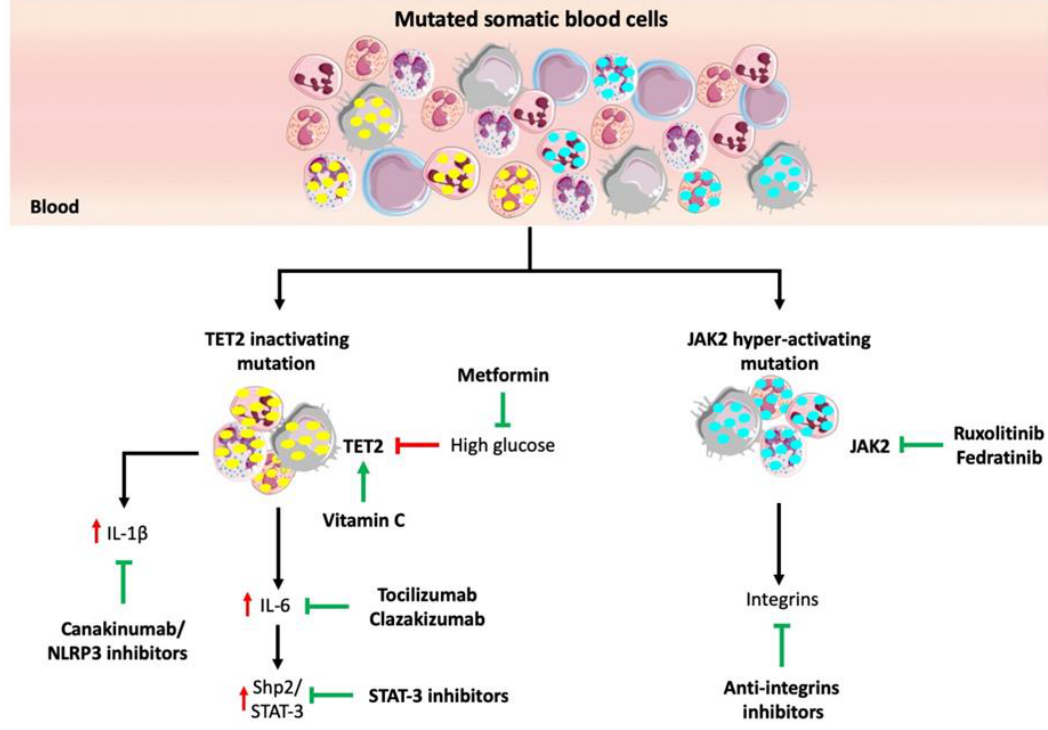
Figure 2. Potential strategies of targeting high-risk CHIP mutations. TET2 deficiency causes the increased expression of IL-1 β and IL-6, which in turn activates the Shp2 / STAT-3 signaling axis. Antibodies targeting IL-1 β and IL-6, NLRP3 or STAT-3 inhibitors could mitigate the e ff ect of a CHIP-mediated inflammation response. High glucose levels destabilize the TET2 protein. Lowering glucose by metformin may rescue TET2 activity. The mutagenic event that determines JAK2 hyperactivation is associated with thromboembolic events. JAK2 inhibitors (ruxolitinib or fedratinib) or anti-integrin inhibitors may reduce atherothrombotic complications.